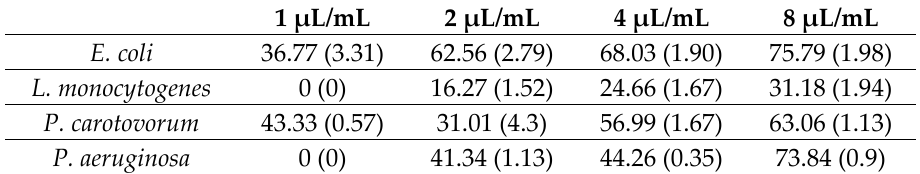
Table 2. Inhibitory action of Opuntia ficus - indica seeds oil on the formation of biofilm. Results are reported as percent of inhibition respect to the control (% = 0). They are the mean (± SD) of three